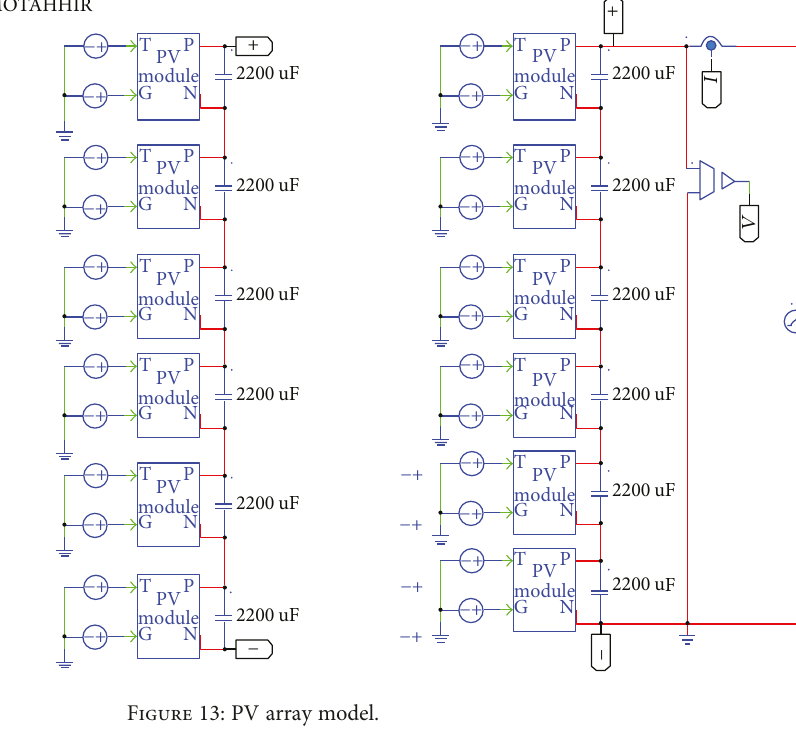
Figure 13: PV array